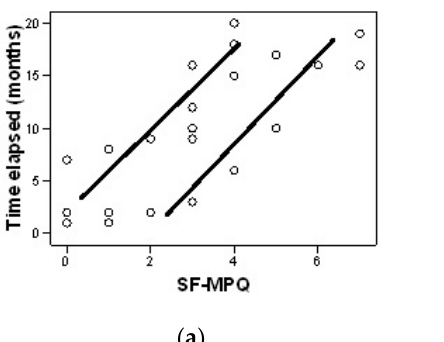
( b ) Control group Figure 2. Correlation between the time elapsed from diagnosis and the disability index after six months for the experimental group ( a ) and control group ( b ). 4. Discussion According to the Global Burden of Disease 2017 Study, the global prevalence and years lived with disability of back pain has increased between 1990 and 2017, registering the maximum prevalence in the 45–49 age group in 2017 [40]. In fact, the first degenerative changes in the disc appear after the age of 30. At the level of the annulus fibrosus there is a decrease in elasticity, while at the level of the nu- cleus pulposus, its hydrophilic capacity decreases, favoring the occurrence of traumatic